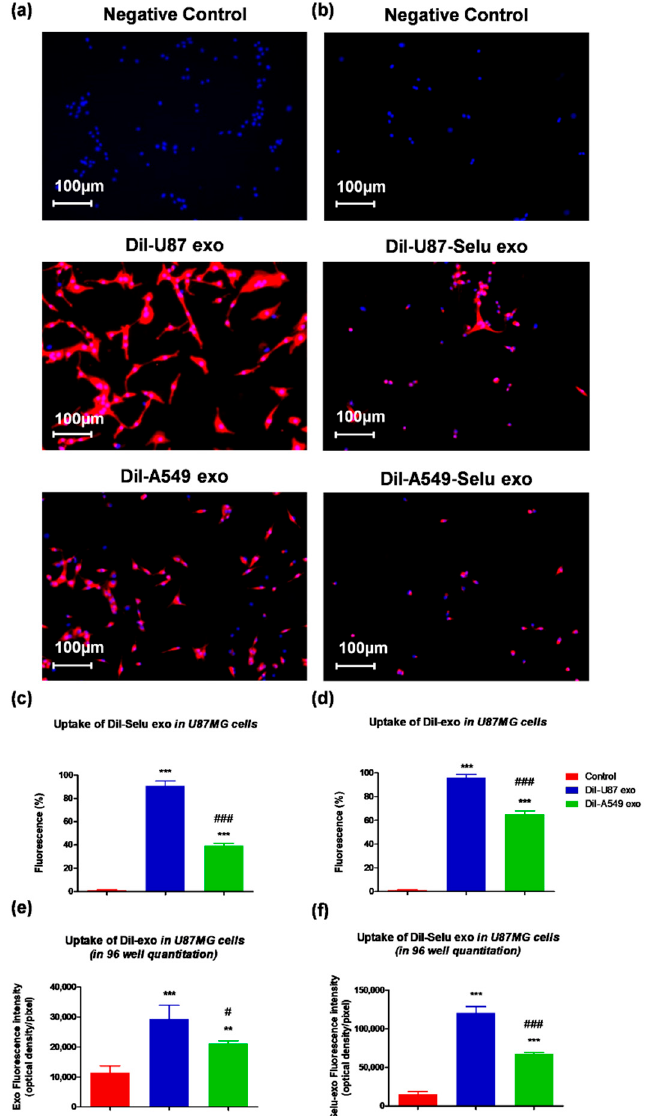
Figure 6. In vitro exosome targeting to U87 cells. ( a , c ) DiI-U87 exo showed higher fluorescence intensity than DiI-A549 exo in U87 cells. *** p < 0.001 vs. non-treated control, ### p < 0.001 vs. DiI-A549-Selu exo. n = 3. ( b , d ) DiI-U87-Selu exo showed higher fluorescence intensity than DiI-A549-Selu exo in U87 cells. *** p < 0.001 vs. control, ### p < 0.001 vs. DiI-A549-Selu exo. n = 3. ( e , f ) In the 96-well plate, the quantitative uptake of DiI-U87 exo and DiI-U87-Selu exo were higher than DiI-A549 exo and DiI-A549-Selu exo. ** p < 0.01, *** p < 0.001 vs. non-treated control; # p < 0.05, ### p < 0.001 vs. DiI-A549-Selu exo. n = 8. Data are represented as mean ± SD.